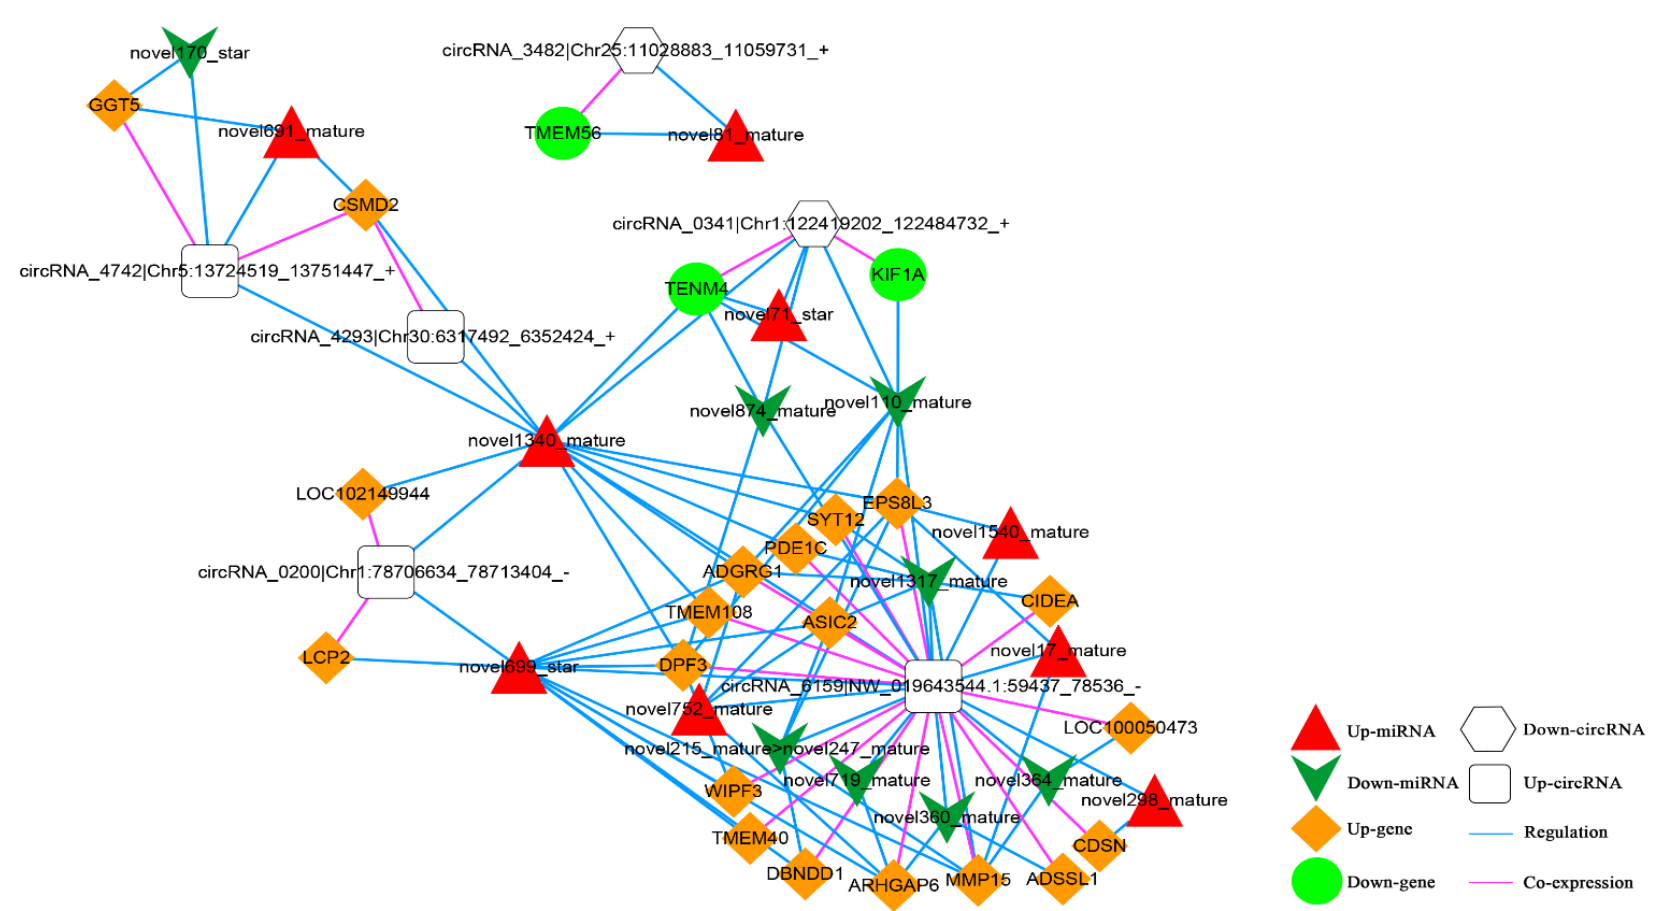
Figure 12. The circRNA-miRNA-mRNA Network. Orange diamond and green ellipse represent the up-regulated and down-regulated genes, respectively; white round rectangle and hexagon show the up-regulated and down-regulated circRNA, respectively; red triangle and green V indicate the up-regulated and down-regulated miRNA, respectively. The pink and blue line represents the co-expression and regulatory relationship, respectively.